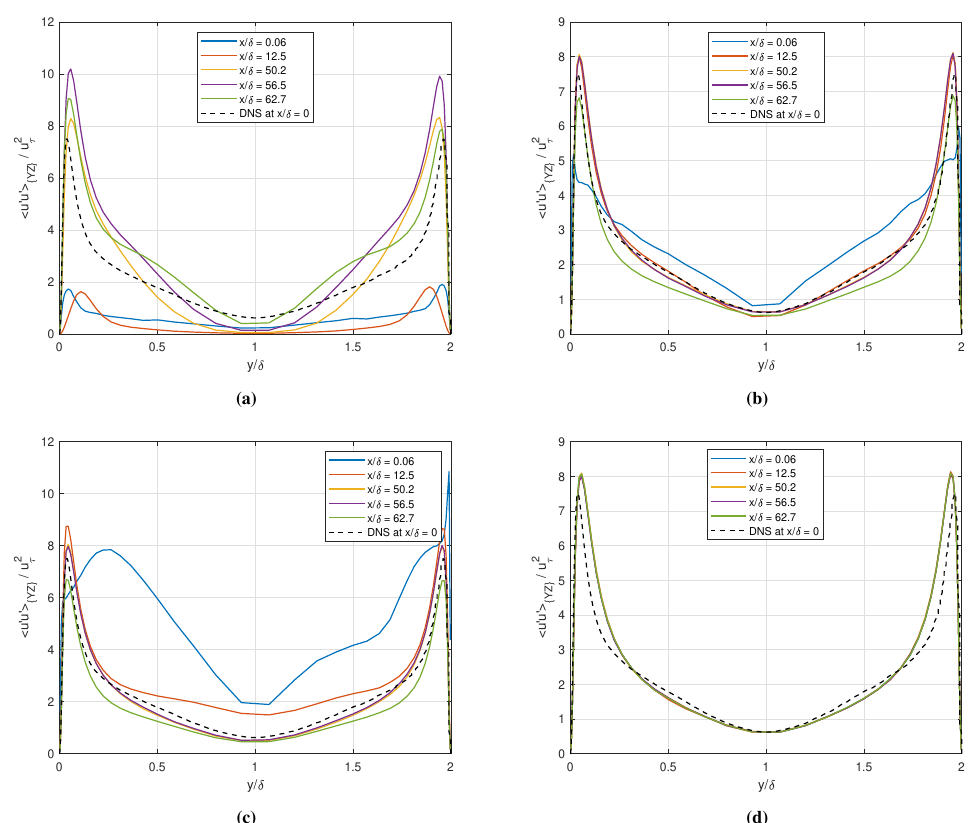
u 0 u 0 Figure 3: profiles at selected streamwise locations using various inlet conditions Figure 3. u (cid:48) u (cid:48) profiles at selected streamwise locations using various inlet conditions as ( a ) 1 cell Per Eddy ( b ) 3 cells Per h i (cid:104) (cid:105) Eddy ( c ) 5 cells Per Eddy ( d ) Periodic.